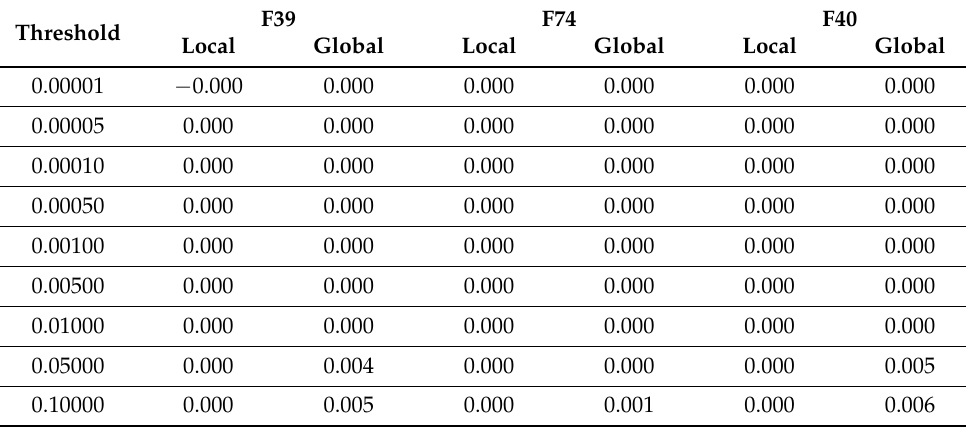
Table 13. pathfinder —local and global approximation propagation error